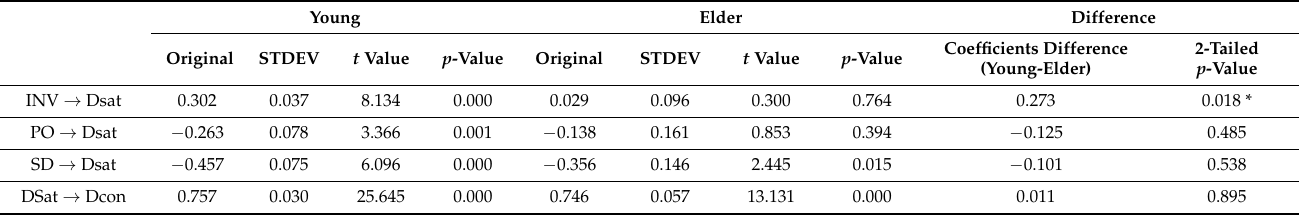
Table 8. Multi-group analysis of young and elder